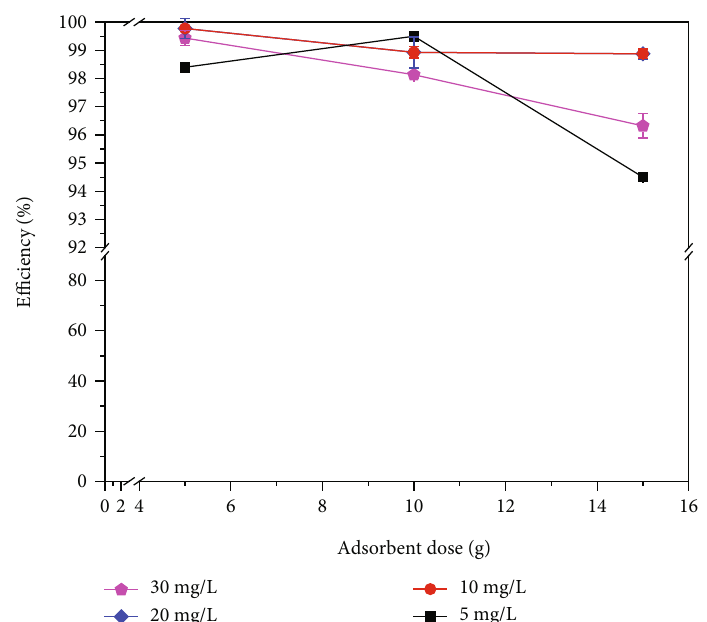
Figure 4: E ff ect of adsorbent dose on percentage removal of Cr(VI) by SSAC ( Co = 30 mg/L , 20mg/L, 10 mg/L, and 5 mg/L; adsorbent dose 5g, 10 g, and 15 g; agitation speed = 120rpm ; time = 180minutes ).